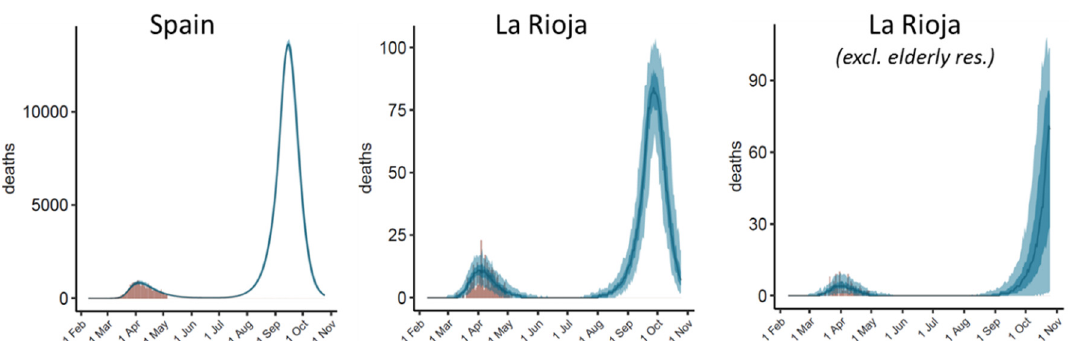
Figure 7. Forecast for daily deaths in Spain and La Rioja over the upcoming months (total data, after excluding data from elderly residences) assuming R t = 1.0 between 11 May and 22 June 2020 and R t = 1.8 afterwards.